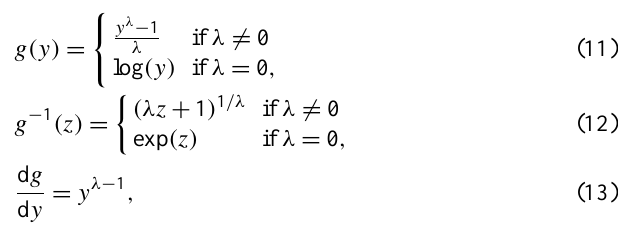
Table 1. Prediction performance metrics for the different error models: iid untransformed error model (iidE), Box-Cox transformed (iidE.BC), and log-sinh transformed (iidE.ls), constant untransformed bias (CtB), Box-Cox transformed (CtB.BC), and log-sinh transformed (CtB.ls), input-dependent untrans- formed bias (IDB), Box-Cox transformed (IDB.BC), and log-sinh transformed (IDB.ls). The criteria on the left represent the Nash-Sutcliffe index in calibration (NS.cal) and validation (NS.val) phases in the non-transformed space, the percentage of validation data points falling into 95% prediction interval (Cover.val), and the average bound width [l/s] in the extrapolation domain (ABW.val).